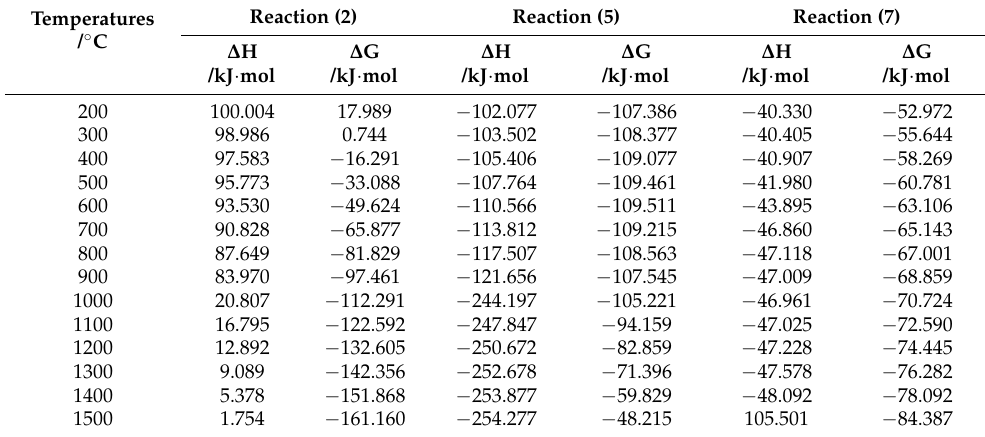
Table 3. Thermodynamic simulation data of Reactions (2), (5), and (7). Reaction Temperatures / ◦ C